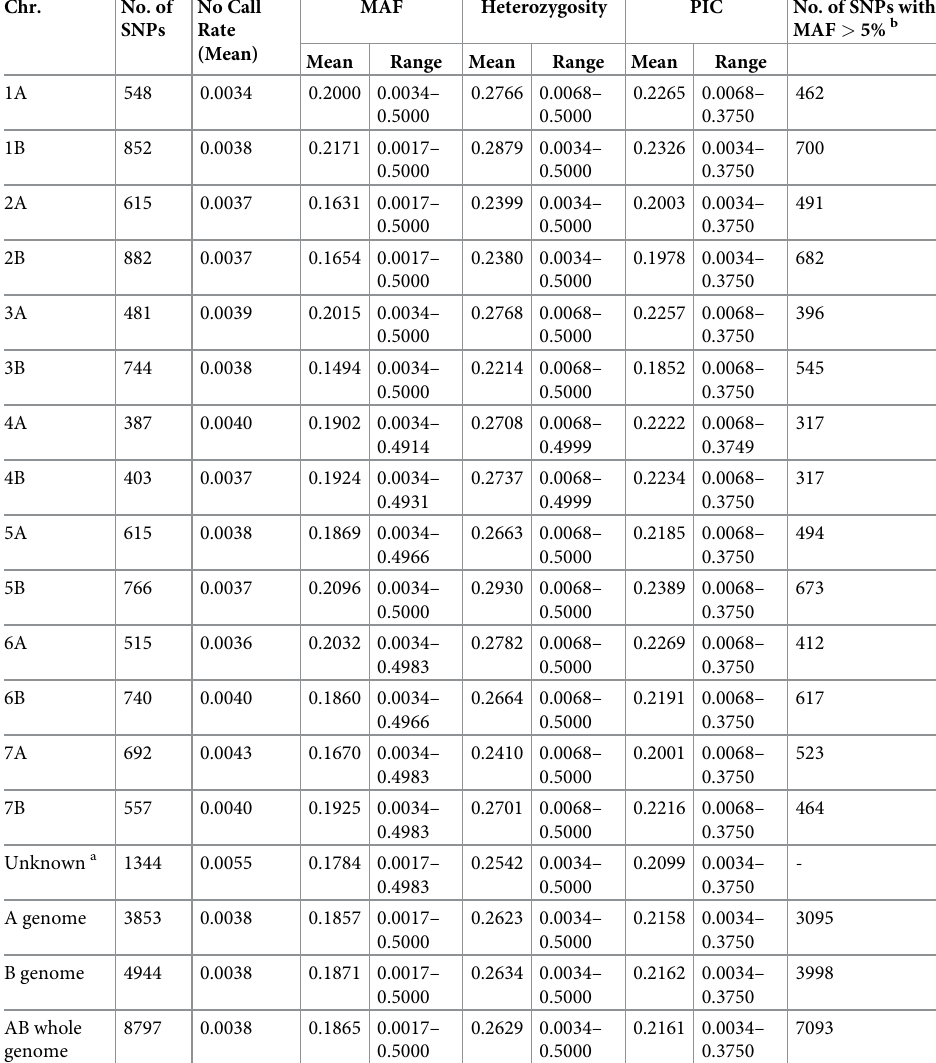
Table 4. Polymorphism of SNPs in Ethiopian durum wheat germplasm obtained from genotyping with Breeders’ 35K Axiom Array.